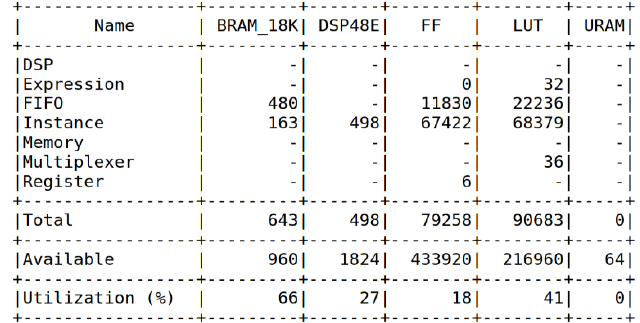
Figure 12. Device utilization for FPGA chipset “xcku5p-ffvb676-1-i”. Table 1. Comparison of accuracy for test data and response speed between CPU and FPGA. Category